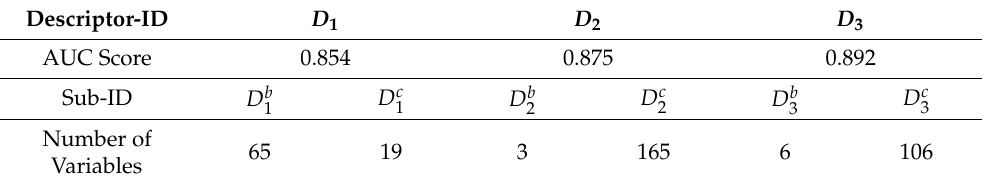
Table 5. Two parts of each descriptor divided by forward step feature selection method via SVM classifier.